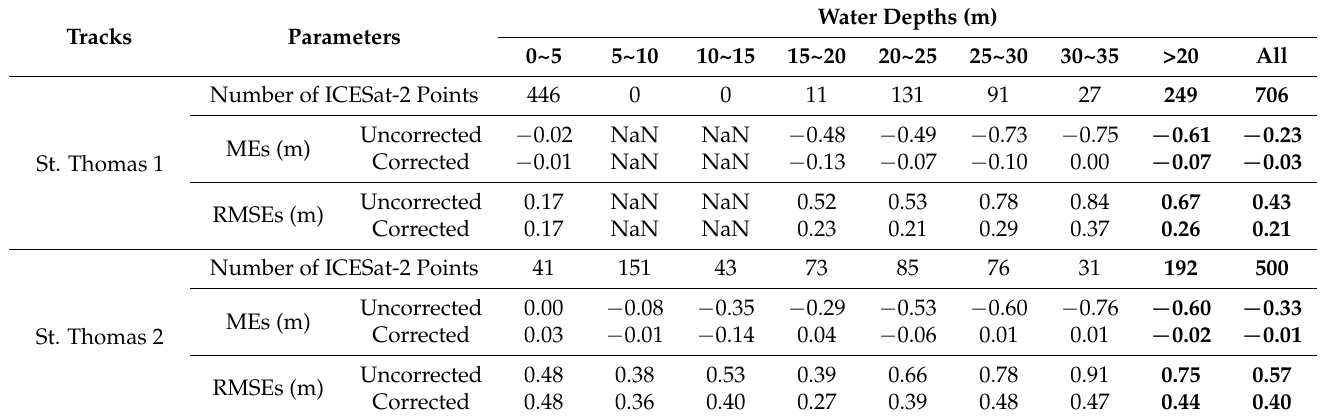
Table 3. Statistics of orthometric height differences between ICESat-2 points and their corresponding truth values before and after water forward-scattering corrections at St. Thomas island. The mean errors (MEs) are the orthometric height differences between ICESat-2 and in situ data, i.e., a minus value means that the orthometric height of an ICESat-2 bathymetric point is underestimated or the water depth is